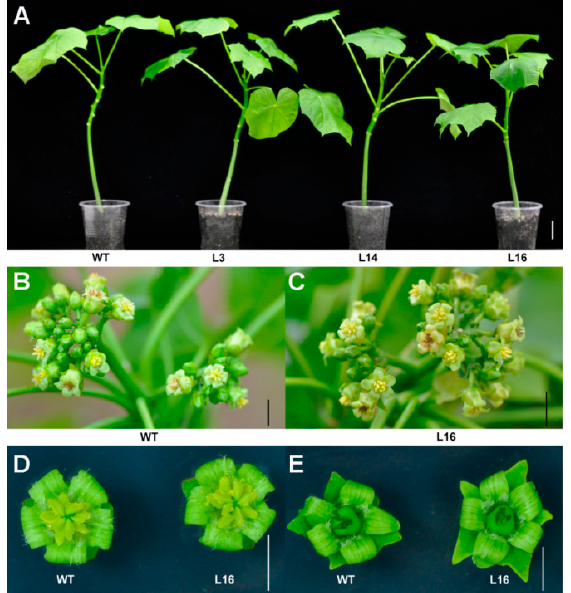
Figure 9. Phenotypes of 35S:JcTPPJ transgenic Jatropha . The 30 ‐ day ‐ old seedlings of wild ‐ type (WT) and transgenic lines (L3, L14, and L16) ( A ). The inflorescences of WT ( B ) and 35S:JcTPPJ transgenic line L16 ( C ) Jatropha plants in the field. Male flowers ( D ) and female flowers ( E ) of WT and transgenic line L16 plants. The bars represent 1.0